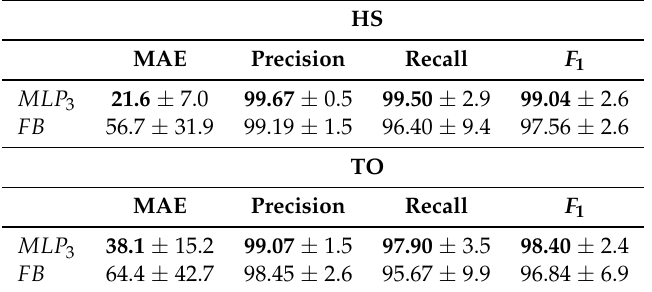
Table 5. Performance of toe-off (TO) and heel-strike (HS) detection for unlearend subjects over 23 folds. HS MAE Precision